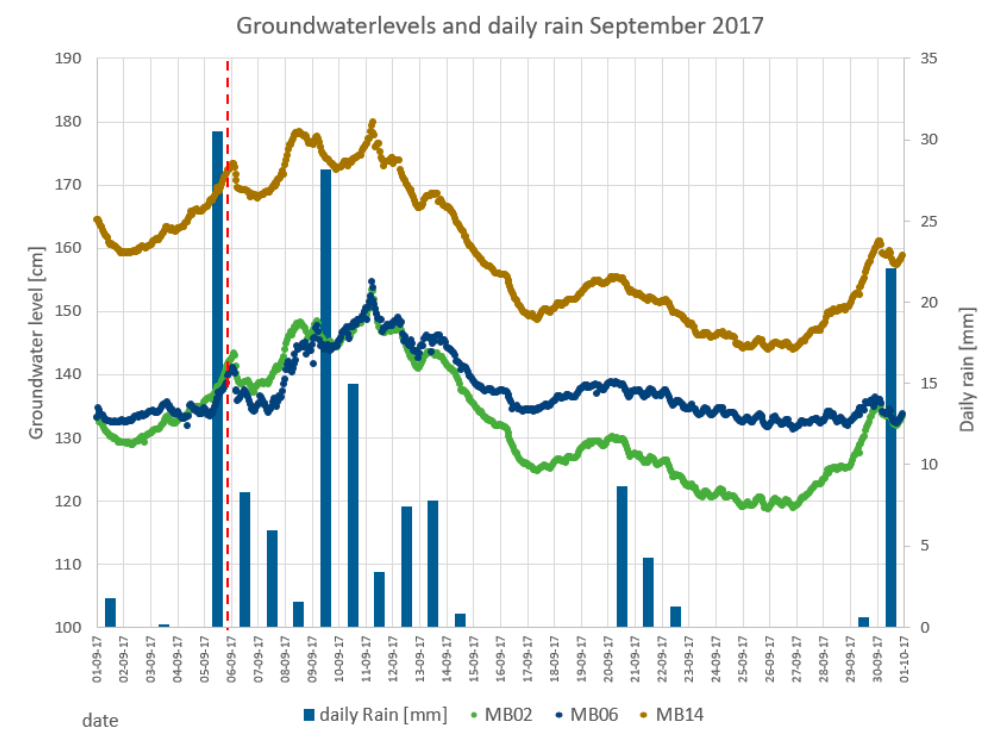
Figure 12. The graph shows variations in the groundwater level (cm) in monitoring wells MB 02 (green line), MB 06 (blue line), and MB 14 (yellow line). The red dashed line marks the day of the full-